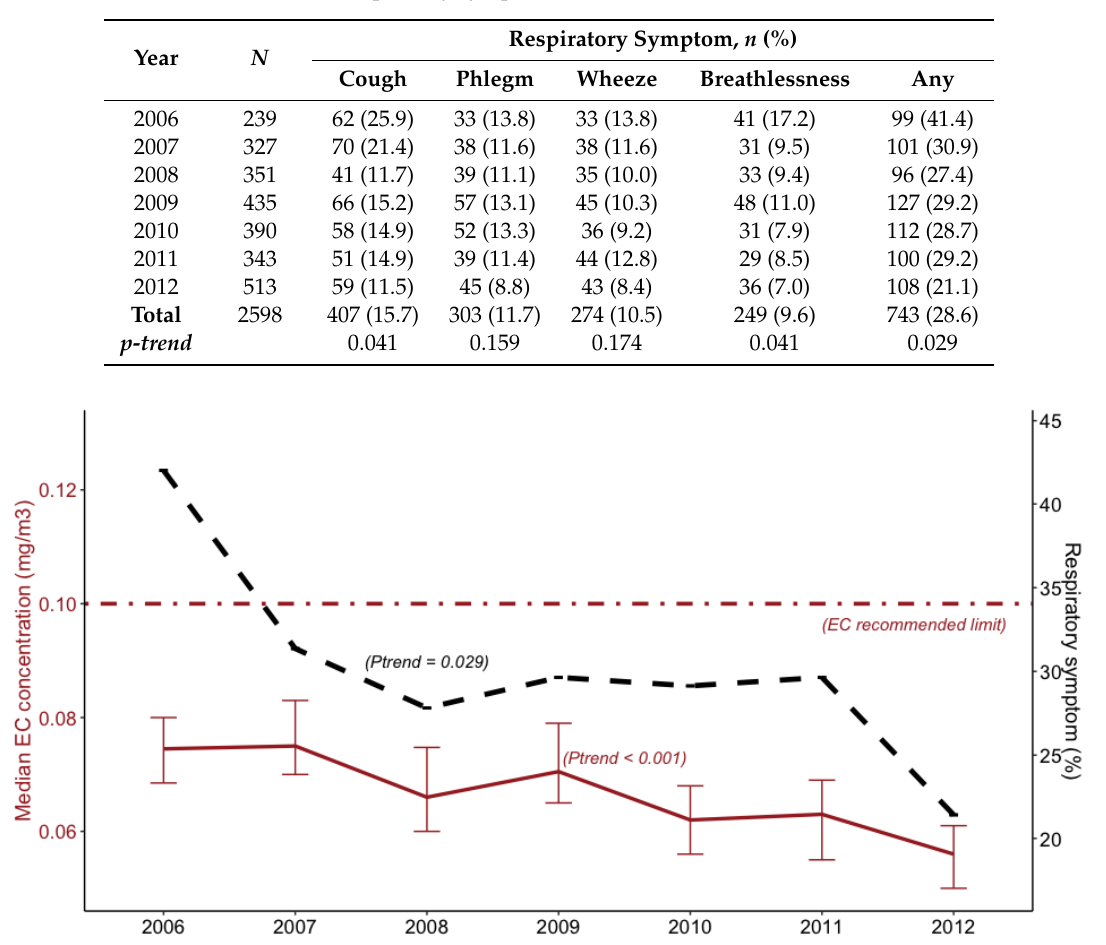
Figure 1. Median elemental carbon concentration (solid line) and prevalence of any respiratory symptom (dotted line) of Western Australian miners, 2006–2012.